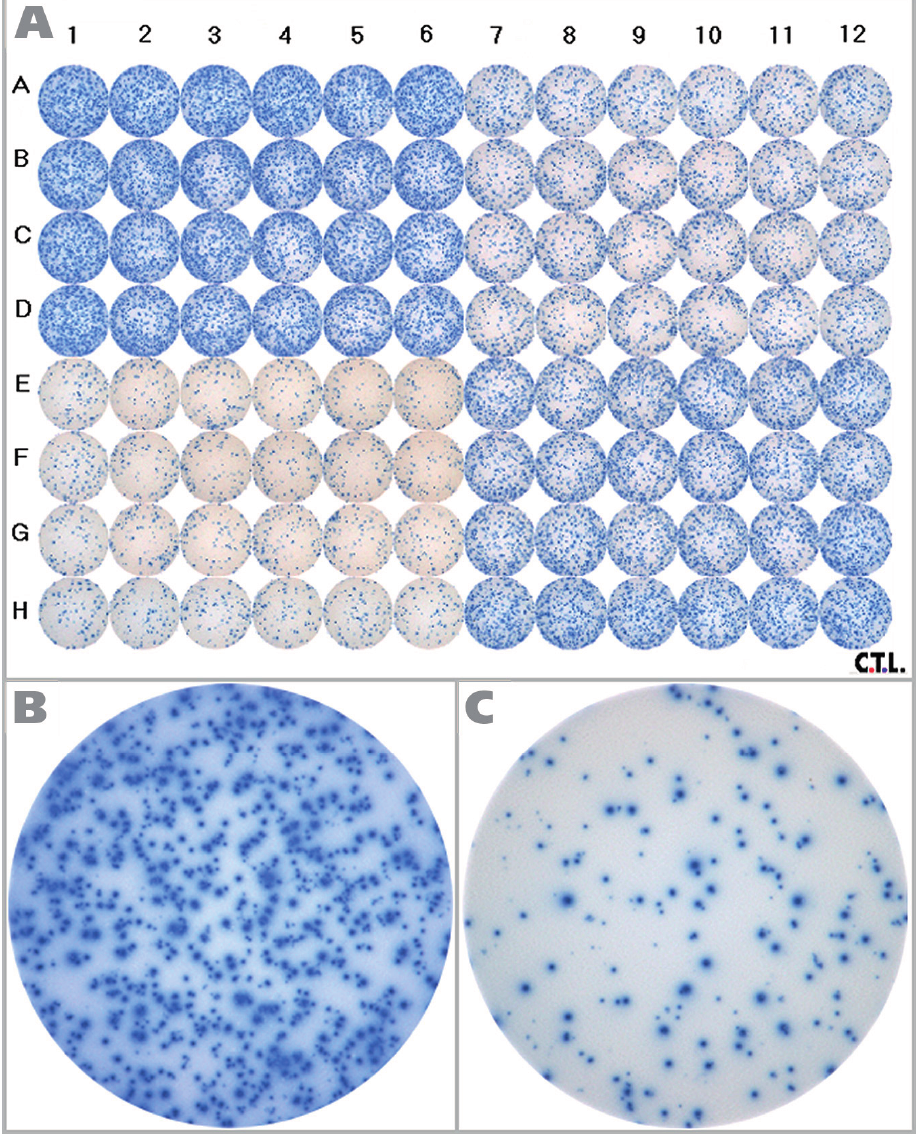
Figure 1. The reference plate used in the study is shown here. ( A ) The Reference Plate was divided into four quadrants. PBMC were plated at 2.0 × 10 5 (upper left quadrant), 1.5 × 10 5 (lower right quadrant), 1.0 × 10 5 (upper right quadrant) and 0.5 × 10 5 (lower left quadrant) cells per well, with 24 replicate wells each. HCMV pp65 antigen was added to all wells at 2 μ g/mL, and after 24h incubation the spots were visualized. Enlarged images are shown for ( B ) 2.0 × 10 5 cells/well and ( C ) 0.5 × 10 5